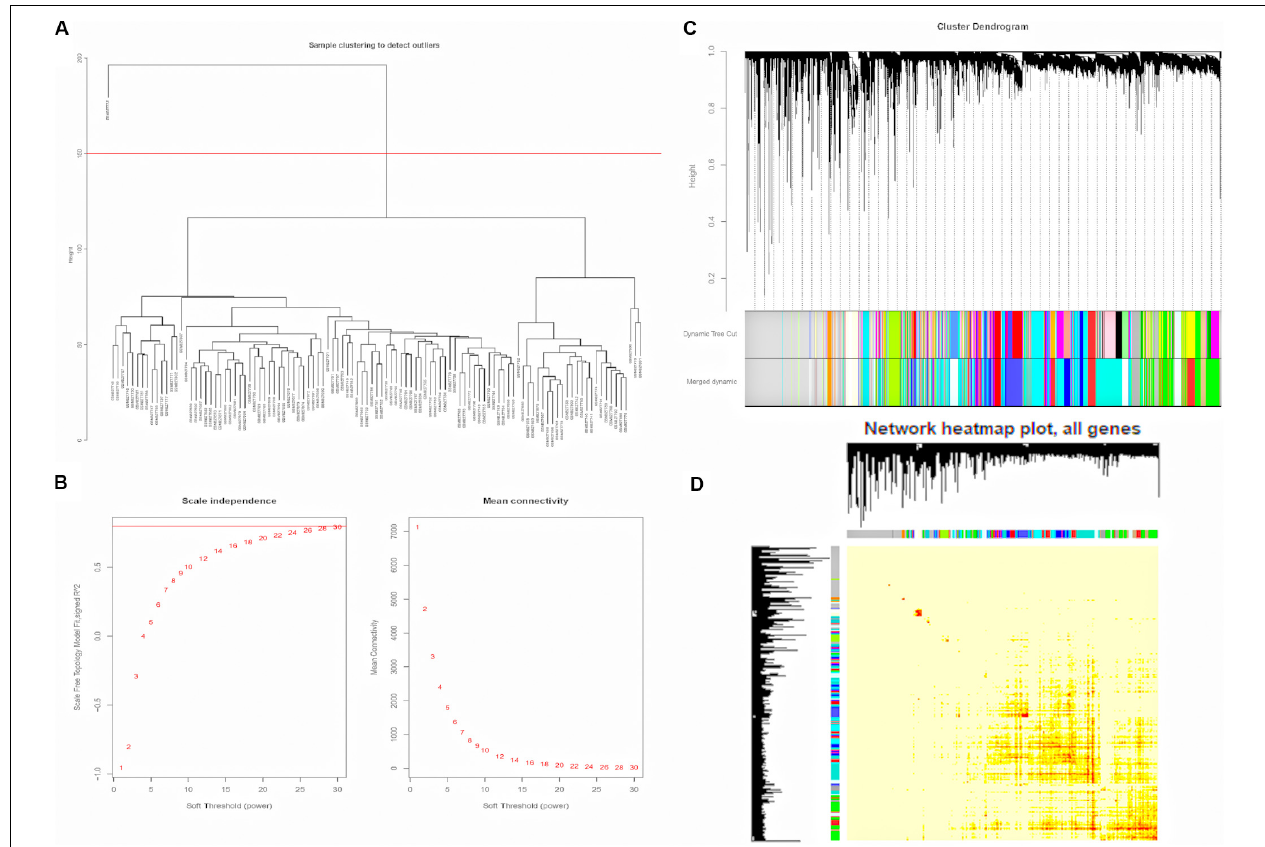
FIGURE 2 | Construction of Weighted Gene Co-expression Network. (A) GSM827775 was excluded from the samples. (B) Analysis of the scale-free topology model fit index for soft threshold powers ( β ) and the mean connectivity for soft threshold powers. (C) The cluster dendrogram of genes in GSE33463. Each branch means one gene. Each color means one co-expressed module. (D) Interactive relationship analysis of co-expression genes. The light color indicates topological overlap, while the darker color indicates a high topological overlap. PAH, pulmonary arterial hypertension; ILD, interstitial lung